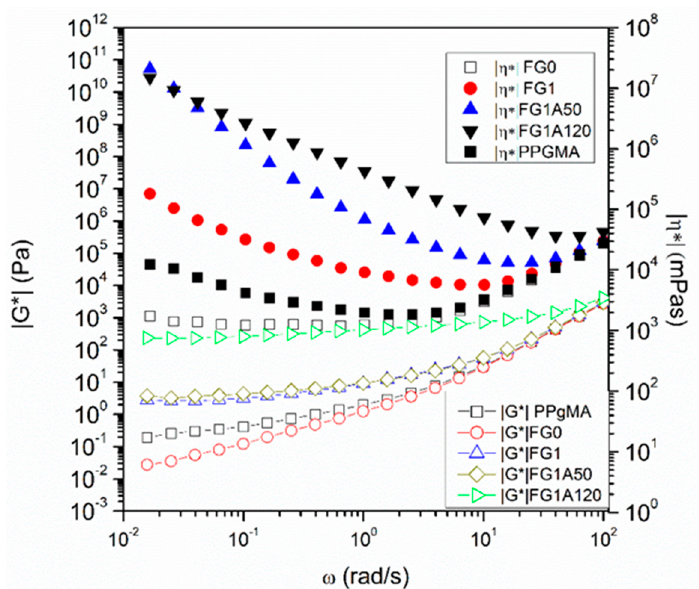
Figure 10. Complex modulus (|G*|) and complex viscosity (| η *|) of PPgMA and its derivatives at various angular frequencies ( ω , rad/s) and measured at temperature of 160 °C.